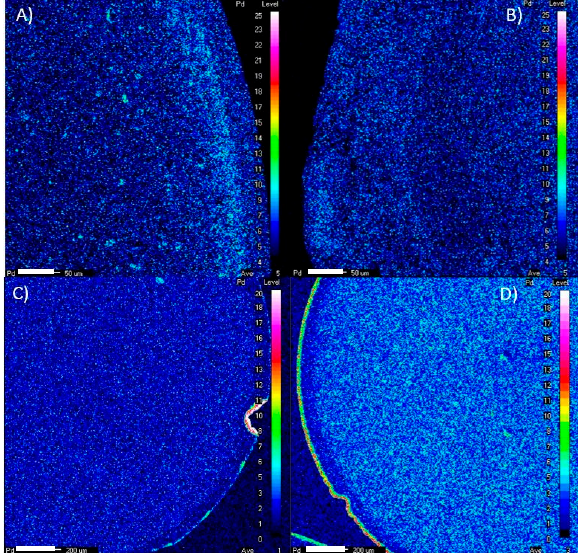
Figure 3. Microprobe cartographies of Pd on the homogeneously dispersed catalysts: ( A ) CP-DI-Ab, ( B ) RP-DI-Ab, scale bar = 50 µ m, ( C ) CP-DI-Ea, and ( D ) CP-DI-Ec, scale bar = 200 µm.